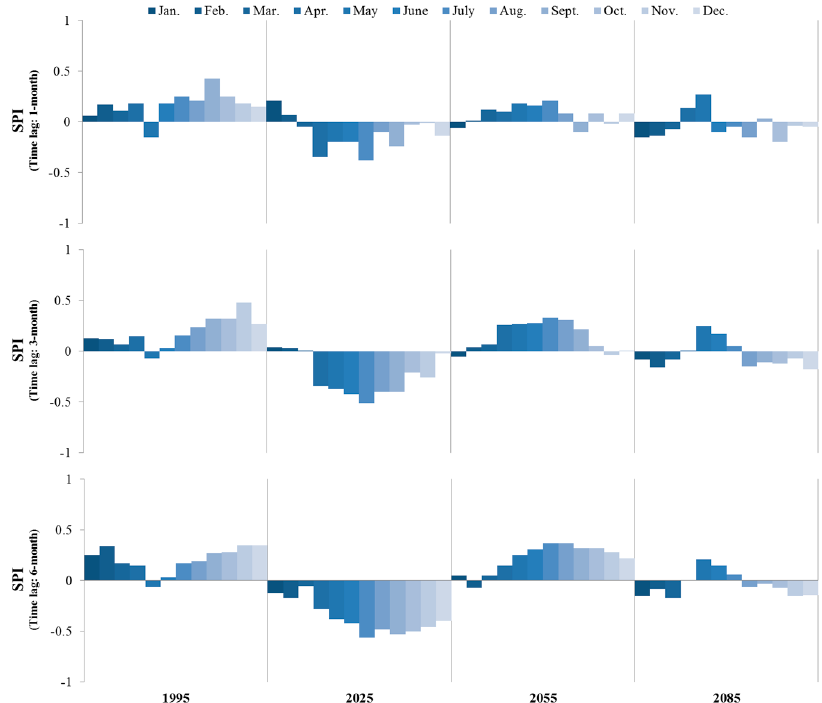
Figure 7. Mean SPI on multiple seasonal timescales.